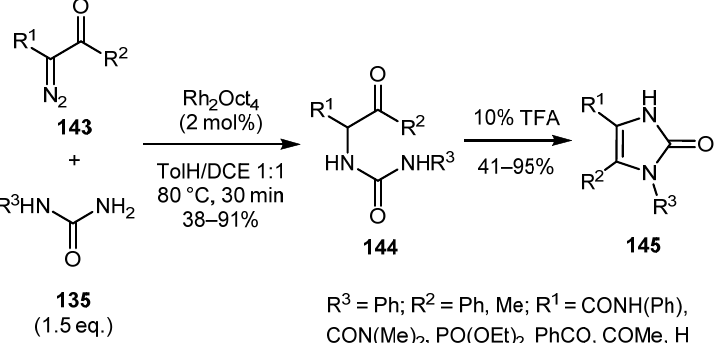
Scheme 32. Synthesis of 2-imidazolones from various diazo carbonyls and primary ureas.